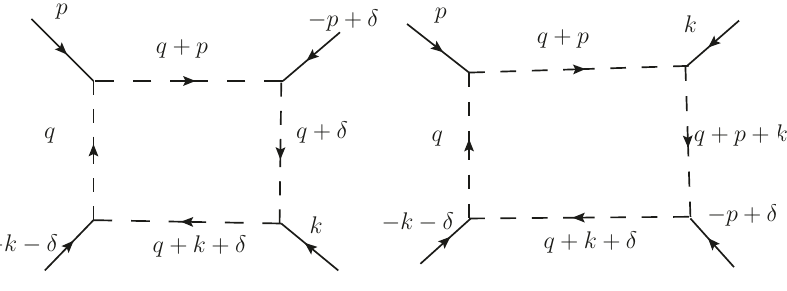
Figure 16. This diagram shows contributions to ~ S ( p;